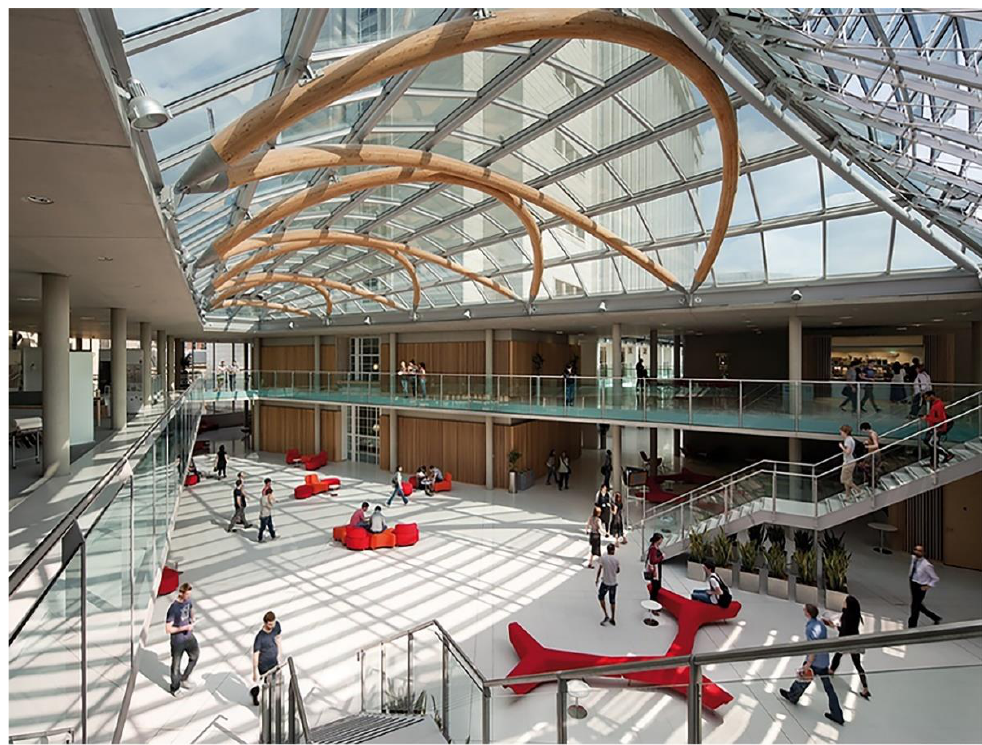
Figure 4. Central Court of Newton at Nottingham Trent University.